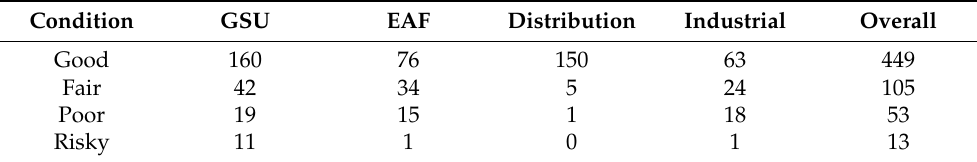
Figure 4. The results of the analysis of the power transformer technical condition with the use of a presented health index for selected populations: ( a ) generator step-up; ( b ) electric arc furnace; ( c ) distribution; ( d ) industrial. Table 10. The results of technical condition assessment within the specified transformer populations.